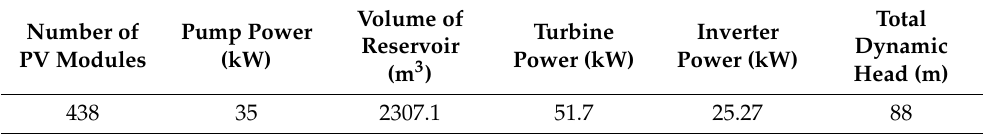
Table 3. The optimal characteristics of the proposed